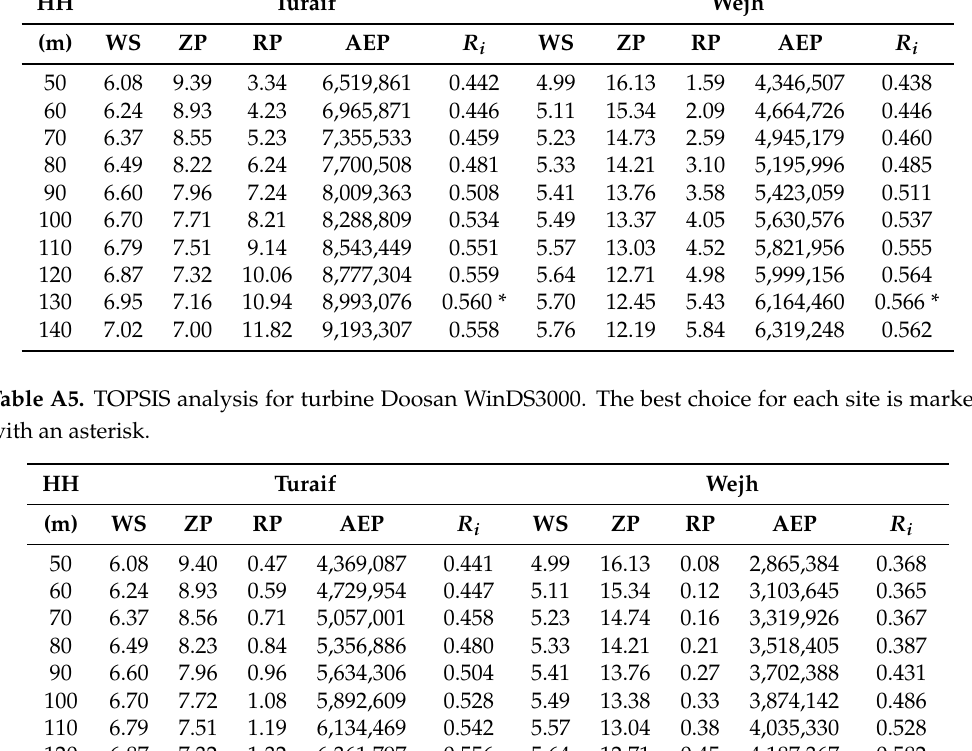
Table A4. TOPSIS analysis for turbine Dongfang DF110-2500. The best choice for each site is marked with an asterisk. HH Turaif Wejh